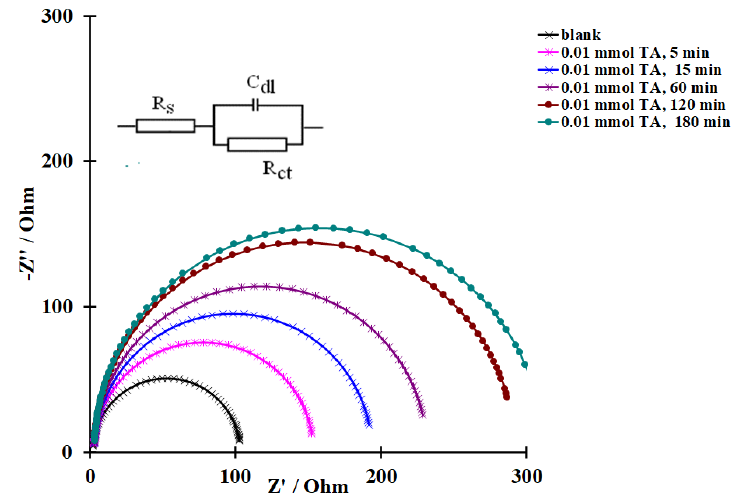
Figure 6. Equivalent electrical circuit and Nyquist plots of a steel electrode (0.64 cm 2 ) in 2.0 M HCl recorded after adding 0.01 mmol TA to the solution with various exposure